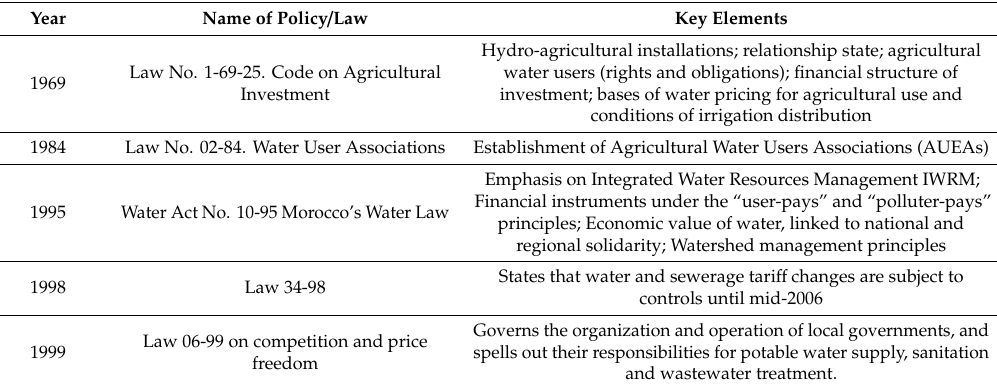
Table 3. Key elements of water governance in